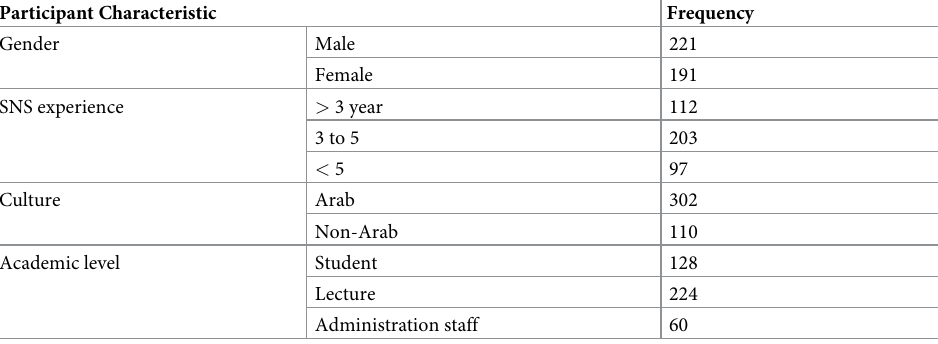
Table 3. Participant characteristic distribution for the